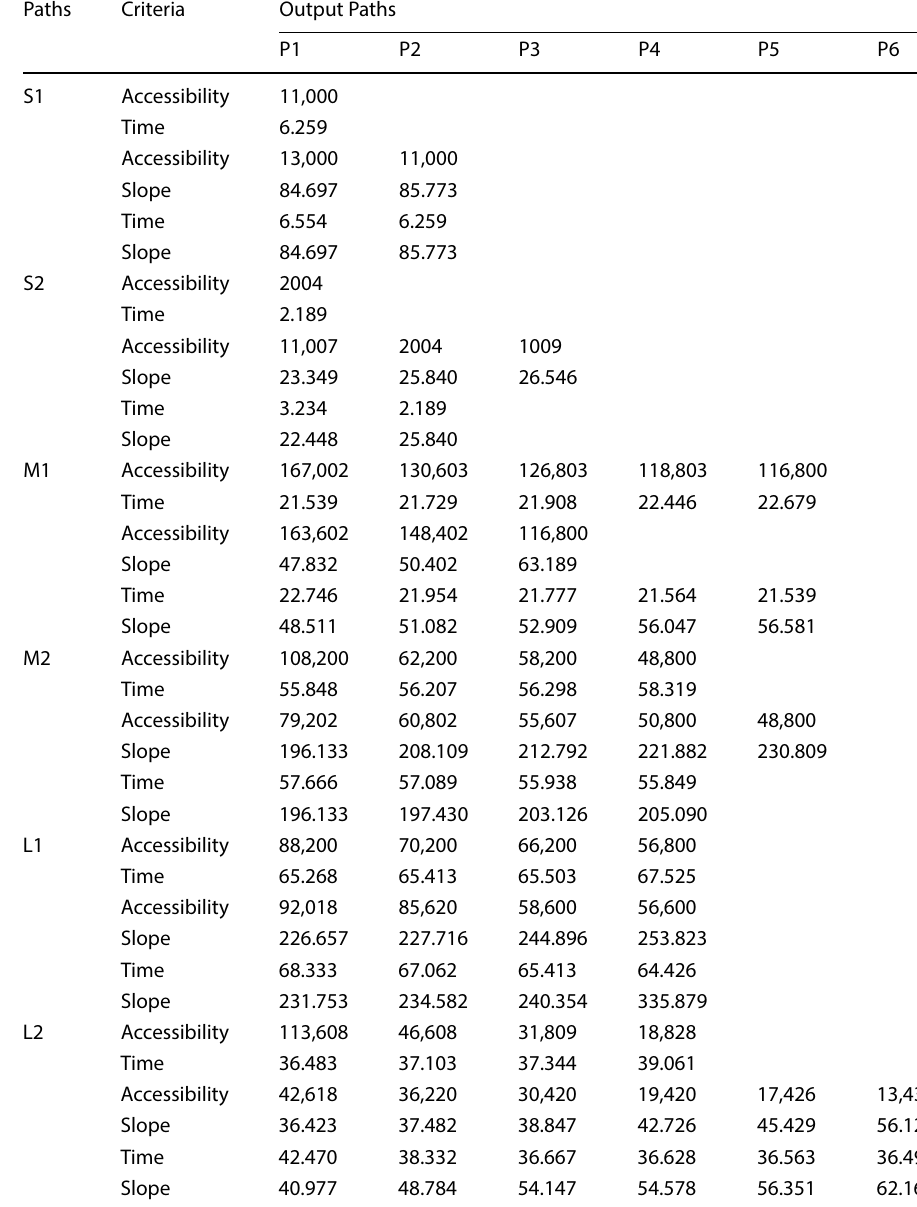
Paths Criteria Output